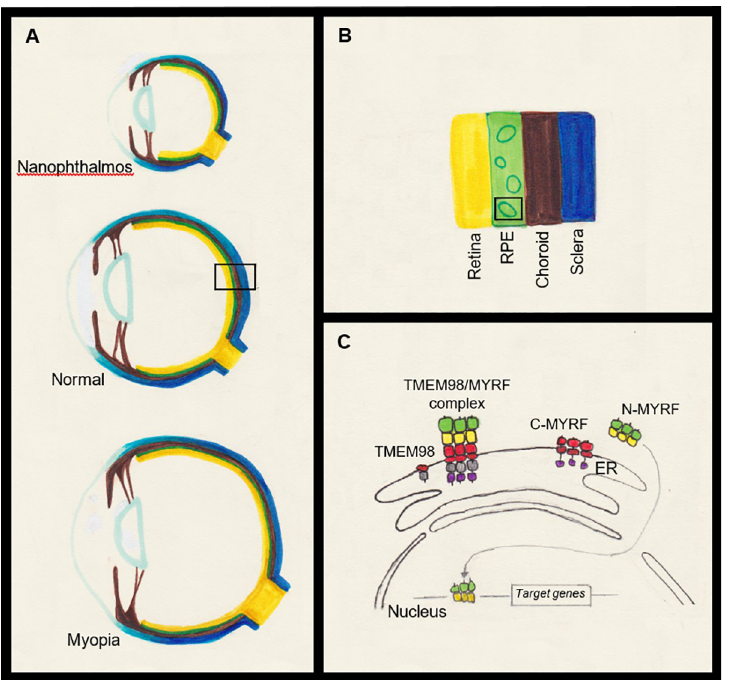
Fig 1. TMEM98 and MYRF in eye size regulation. A. Schematic drawing of the human eye. The eye size is an important factor in determining proper focus of images on the retina, and its regulation is complex. If the axial length is too short, hyperopic refractive error may occur. An extreme example is nanophthalmos (A, top). The opposite is myopic refractive error, which commonly results from long axial length (A, bottom). B. Close up view of posterior pole of normal size human eye (A, middle). Multiple layers of retina are condensed as a single layer and depicted in yellow. Retinal pigment epithelium (RPE) is in green, choroid in brown and sclera in blue. C. Close up view of